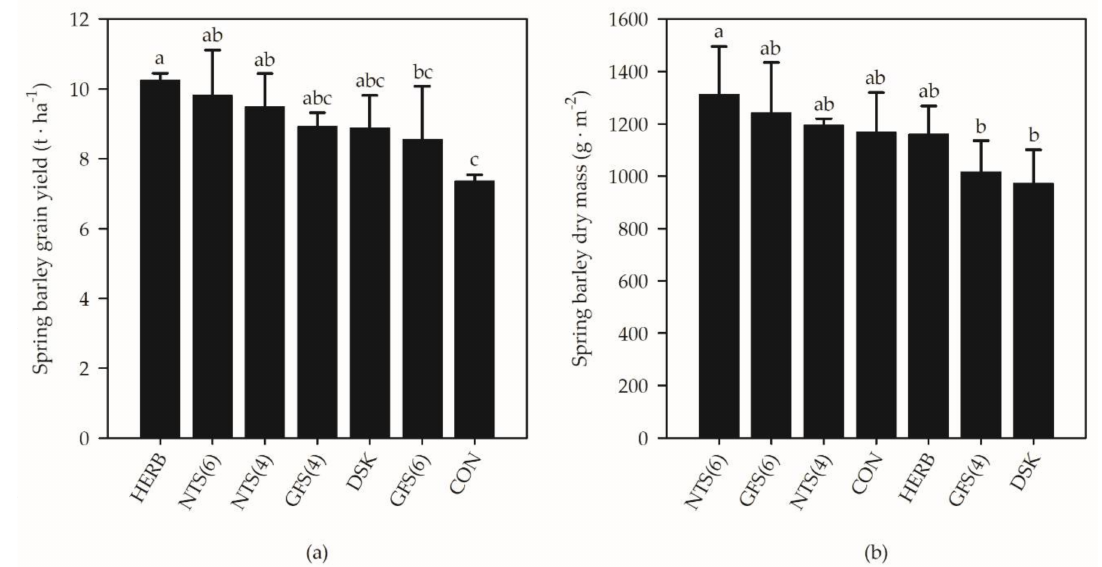
Figure 3. ( a ) Spring barley grain yield; ( b ) spring barley dry mass recorded at Ihinger Hof in 2017. Means with the same letter are not significantly different according to Duncan’s multiple range test at α ≤ 0.05. CON = untreated control, HERB = herbicide application, GFS(4) = goosefoot sweeps 4 km · h − 1 , GFS(6) = goosefoot sweeps 6 km · h − 1 , NTS(4) = no-till sweeps 4 km · h − 1 , NTS(6) = no-till sweeps 6 km · h − 1 , DSK = down-cut side knife 4 km · h − 1